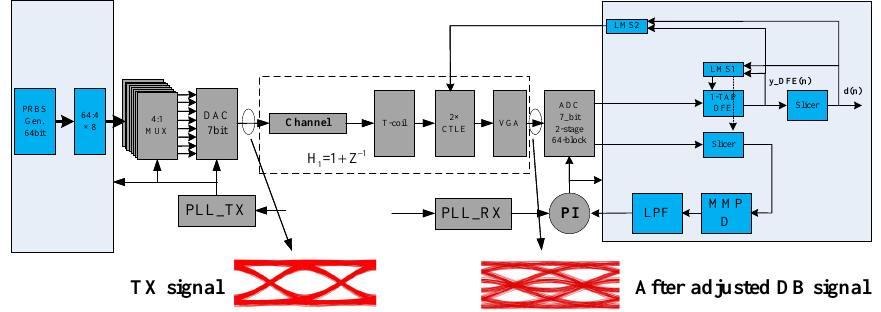
Figure 4. Ideal 1 + z − 1 channel and actual fitting